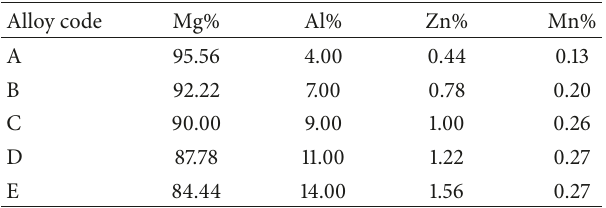
Table 1: Chemical composition of the Mg-Al-Zn alloys used in the present study (wt%).